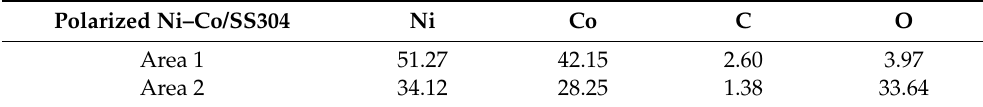
Figure 8c,d show the EDS spectra of the two different regions on polarized Ni– Co/SS304, and the detailed compositions are listed in Table 3. The area without corrosion product accumulation (area 1) mainly contains Ni, Co, C, and O. Compared with the po- larized Ni–Co/SS304 surface, in area 1, the relative content of Ni increases slightly, while the content of Co and C decreases. The content of C has been reduced to close to that before annealing treatment, but the content of O changes little. As shown in Figure 8d and Table 3, the area with corrosion product accumulation (area 2) contains Ni, Co, C, O, and S. In area 2, the relative content ratio of Ni/Co is similar to that of area 1, and the content of C is much lower, while the content of O is extremely high, and a small amount of S appears. The composition difference reveals that the corrosion rate of alloying elements in the Ni–Co alloy coating in these two areas is similar, and the Co dissolves preferentially. The hydrocarbons adsorbed on the Ni–Co/SS304 surface have been separated from the surface after polarization, which may lead to the increase in surface wettability. Table 3. Elements and contents (at.%) of area 1 and area 2 with different morphologies on polarized Ni–Co/SS304 in Figure